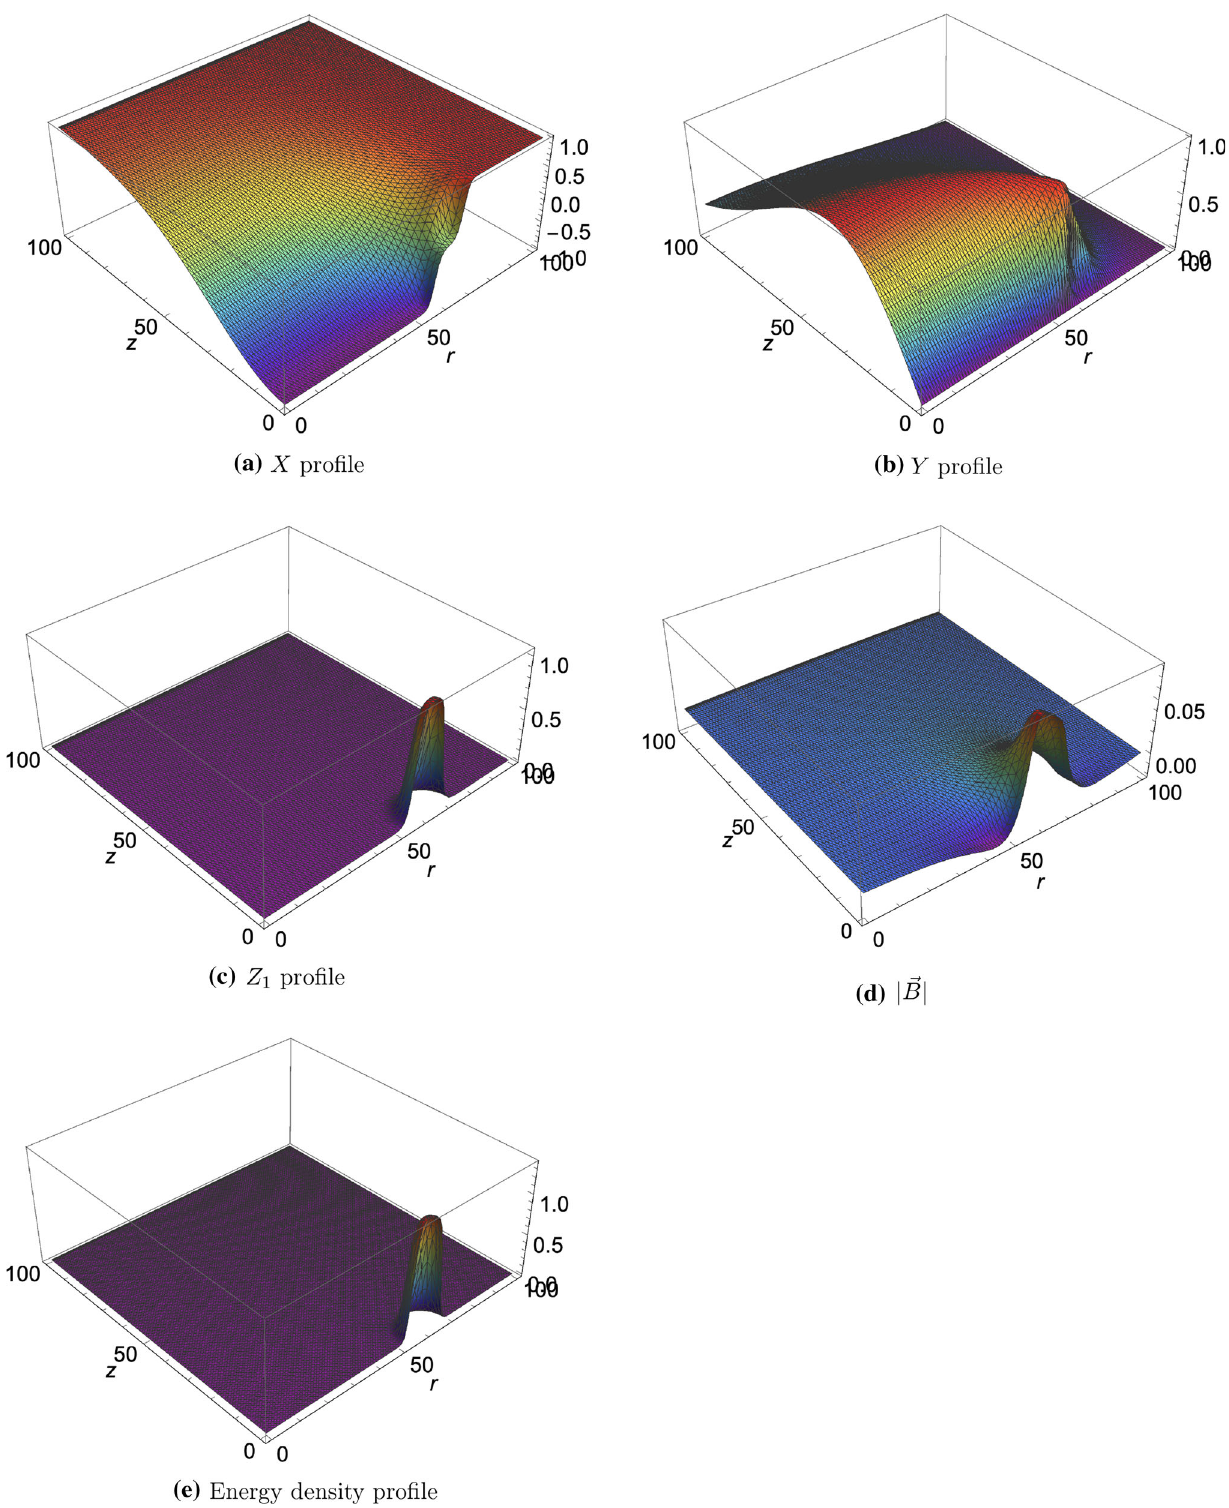
Fig. 4 Vorton profiles for X , Y , and Z 1 components. The magnetic field | (cid:8) B | = B φ = ∂ r A z and energy density profile are also shown. The parameters are n = 1, m = 40, λ φ = 4 . 5, λ σ = 4 . 0, γ = 2 . 8, Q = 60000, g = 0 . 1. For this value of Q , we find ω = 0 .